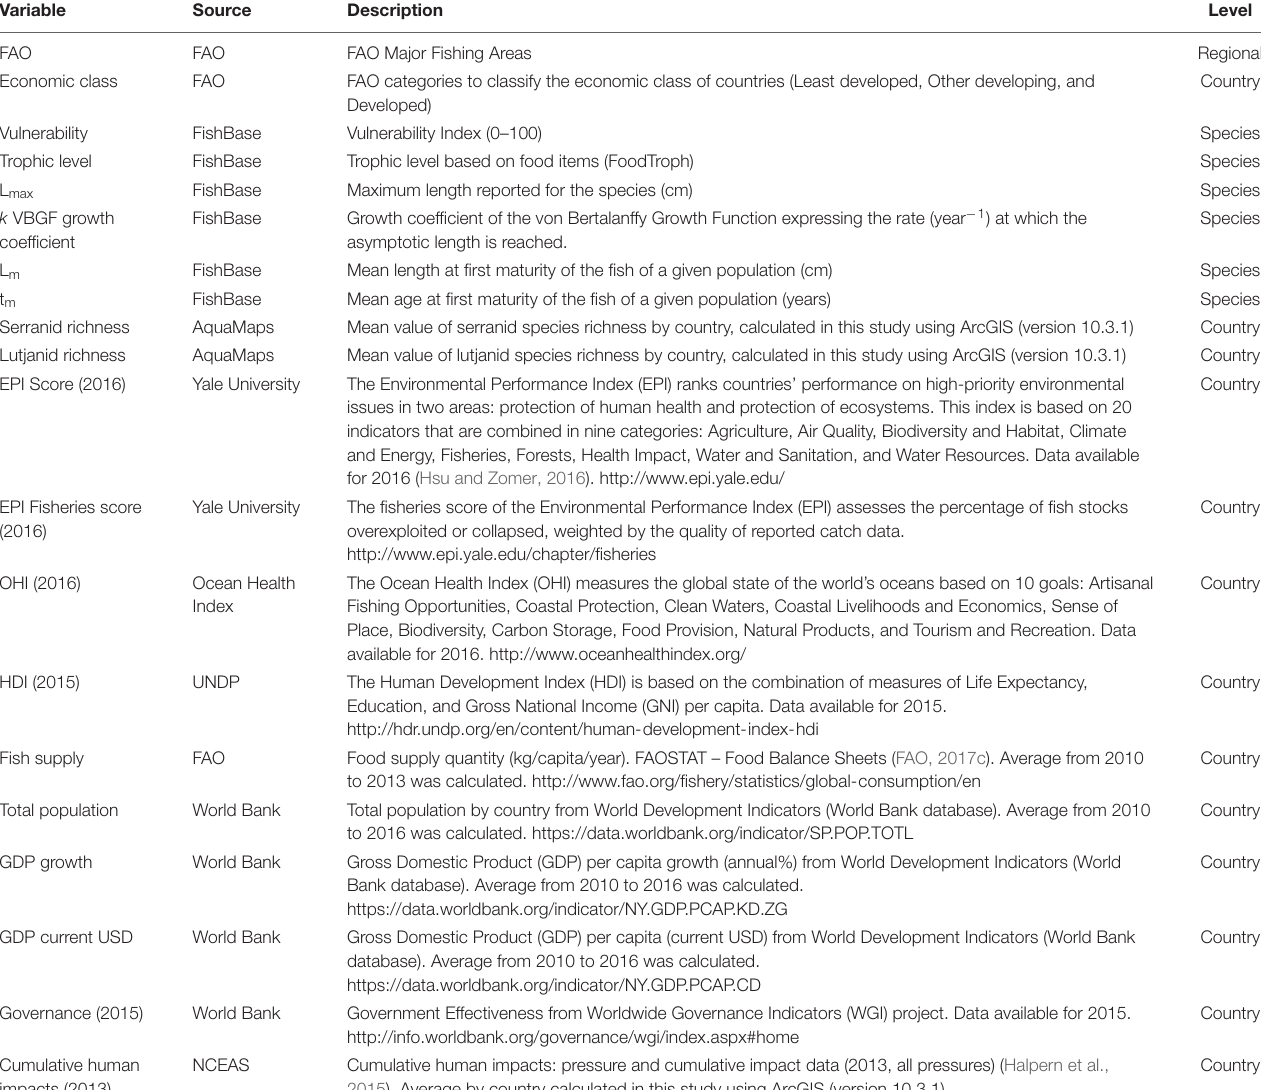
TABLE A1 | Description of the variables included in the database and used for the